Question: Give a one-sentence summary of this figure.
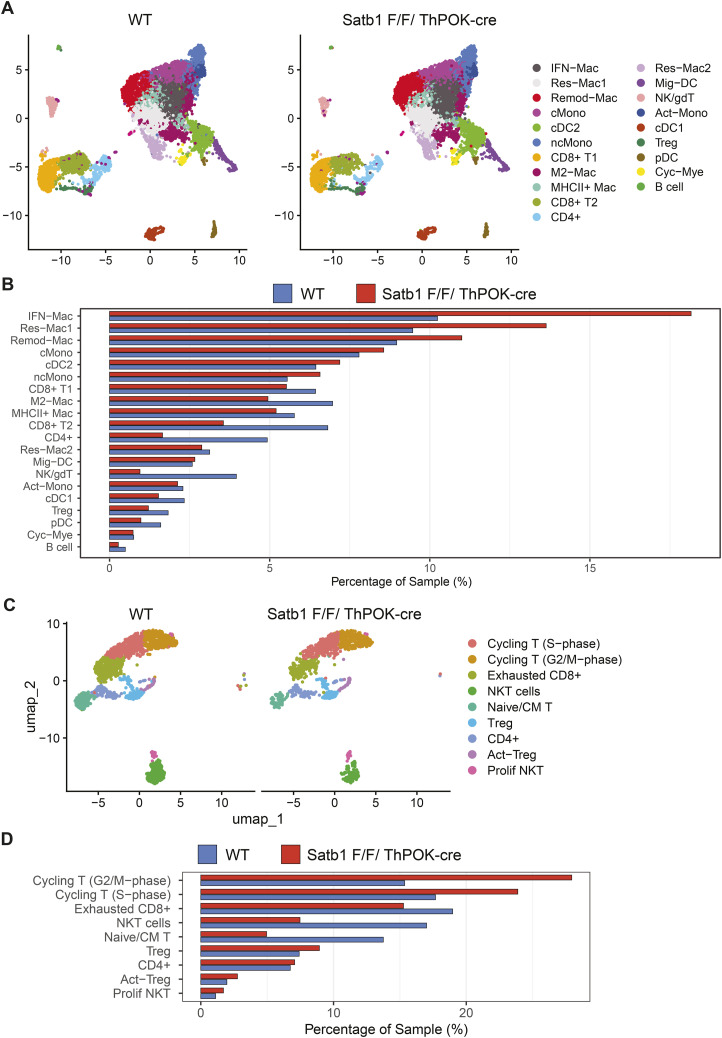
Answer: Single-cell RNA-sequencing analysis of tumor-infiltrating immune populations. (A) Split UMAP visualizations of all sorted CD45 + tumor-infiltrating lymphocytes isolated from WT and Satb1 F/F :Thpok-cre mice. (B) UMAP projection denoting the 20 identified major immune cell clusters across both genotypes, including various macrophage, monocyte, dendritic cell, and lymphocyte lineages. (C) Isolated UMAP re-clustering of T-cell subpopulations, displaying the distribution of distinct T-cell states (e.g., naive/CM T, cycling T, exhausted CD8 + , Treg, Act-Treg) separated by genotype. (D) Bar graphs quantifying the relative sample percentages for the global immune cell clusters and the isolated T-cell subpopulations, highlighting the proportional shifts within the tumor microenvironment after SATB1 deletion.